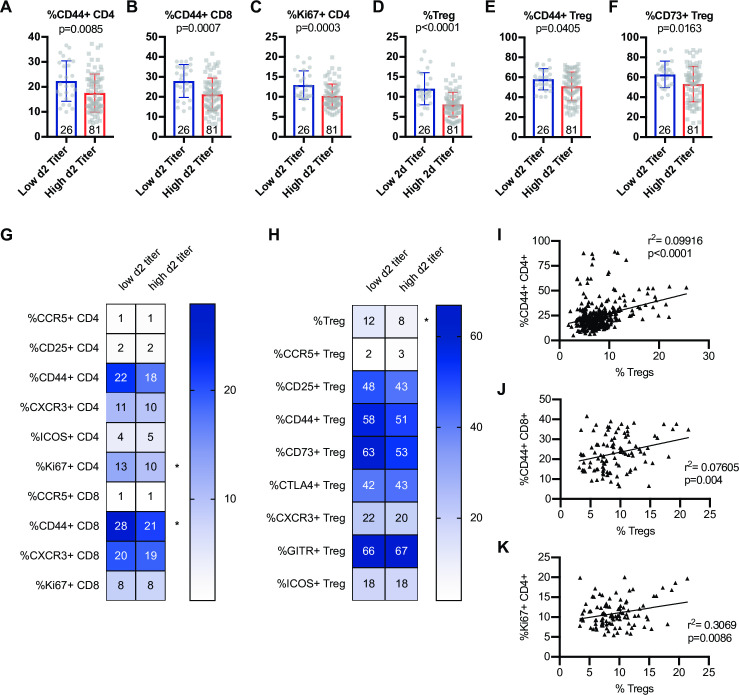
Early virologic control correlates with increased baseline circulating frequency of activated T cells and regulatory T cells.Age-matched female CC-RIX were infected intranasally with SARS-CoV MA15 and lung viral loads at day 2 post-infection were used to select CC-RIX lines with extreme phenotypes: “Low 2d Titer” or “High 2d Titer”, as indicated in Fig 1. Mice from a second cohort of 3–6 age-matched male mice of these selected lines were euthanized and splenic cells analyzed by flow cytometry staining to determine the % of CD4 T cells that are CD44+ (A), the % of CD8 T cells that are CD44+ (B), the % of CD4 T cells that are Ki67+ (C), the % of CD4 T cells that are Foxp3+ Tregs (D), the % of Tregs that are CD44+ (E), and the % of Tregs that are CD73+ (F). Numbers within the histograms indicate the number of data points (mice) per comparison. Statistical significance was determined by Mann-Whitney test, and Bonferroni correction was applied to correct for multiple comparisons so that p<0.0015625 is considered significant. Heat maps were made to compare the average percent of the indicated cell populations for conventional T cells (G) and for regulatory T cells (H). An asterisk indicates statistical significance of p<0.0015625 as calculated above after correction for multiple comparisons. The correlation between the baseline splenic frequency of Tregs (% Foxp3+ of CD4 T cells) and (I) % of CD4 T cells that are CD44+, (J) % of CD8 T cells that are CD44+, or (K) % of CD4 T cells that are Ki67+ are shown with linear regressions for mice from all CC-RIX lines with low or high day 2 titer.